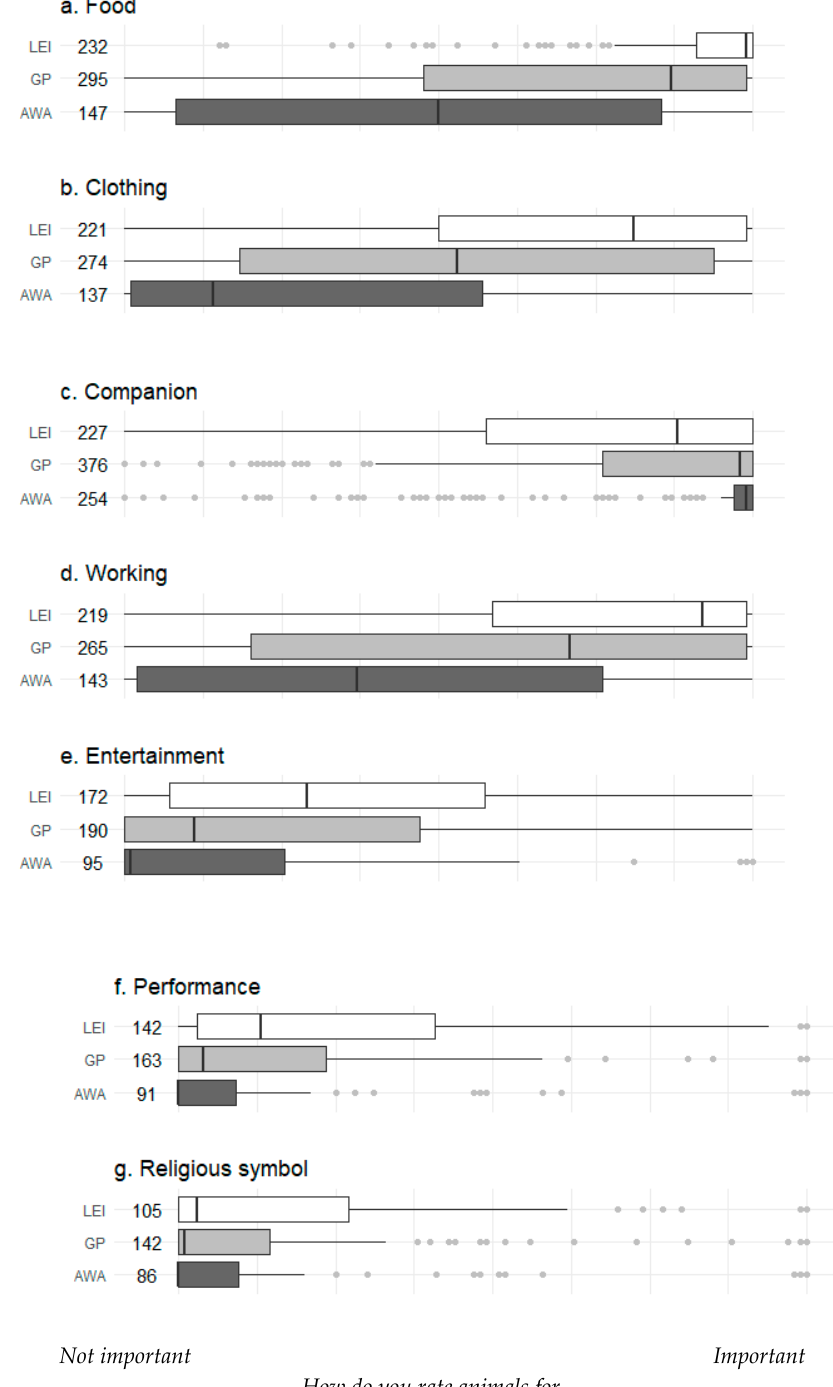
Figure 4. Rating of the importance of animals in various roles by survey respondents grouped into three stakeholder categories: animal welfare advocates (AWAs), general public (GP) or live export industry (LEI) workers. The number of respondents varied for these questions: numbers next to stakeholder groups indicate the number of respondents for each. Data were collected using a visual analogue scale: values are medians (vertical line) and quartiles (boxes) ± non-outlier range (whiskers); dots represent outliers (1.5 × the inter-quartile range). For all these questions, responses differed significantly between the three stakeholder groups (Kruskall–Wallis ANOVA; p < 0.001 for a–f and p = 0.013 for g).